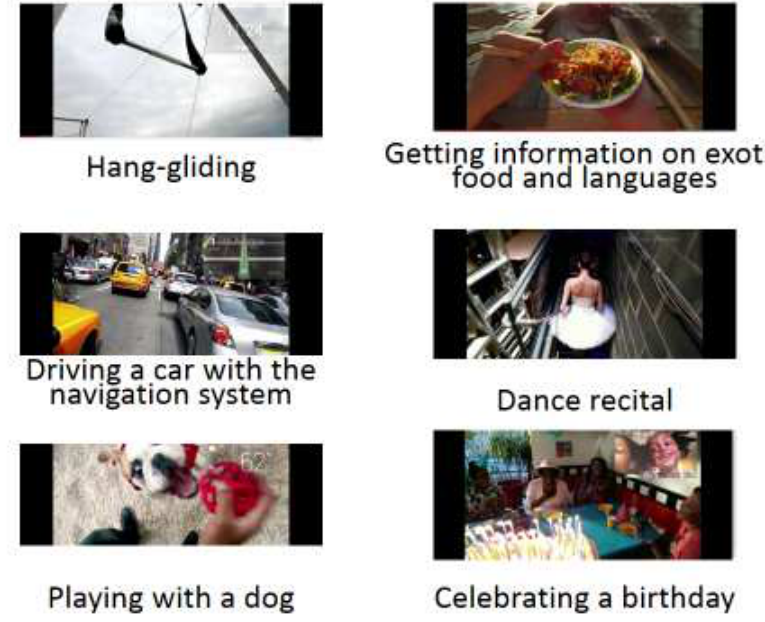
Fig. 2. Empowering (extra)ordinary moments with Google Glass (Screenshots from the Google Glass trailer “How It Feels [through